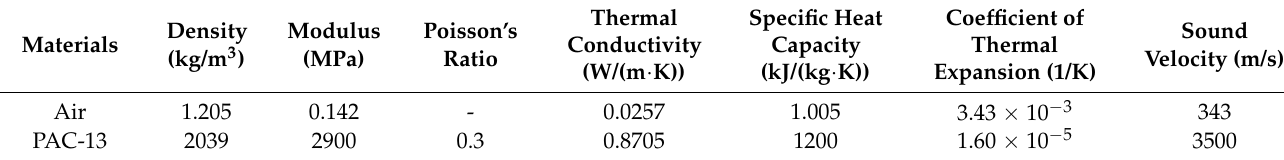
Table 7. Material parameters involved in the simulation.